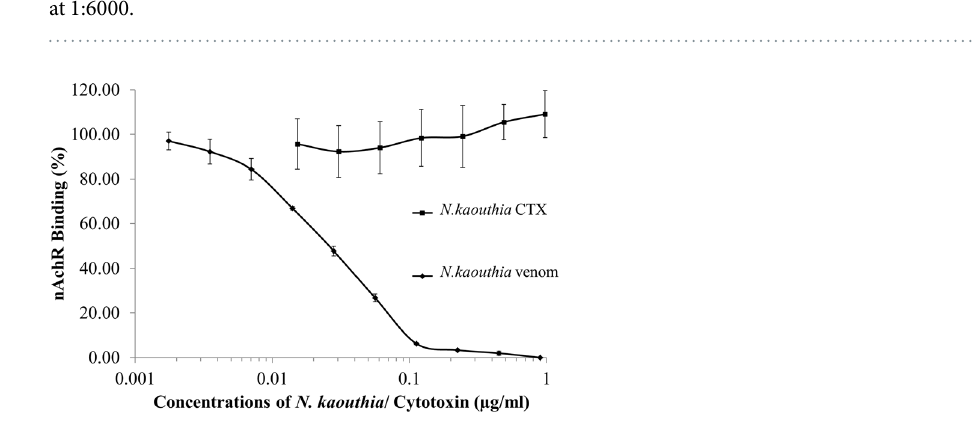
Figure 2. The inhibition of nAChR binding to the NK3 coated-plate by N. kaouthia venom and by N. kaouthia cytotoxin I. nAChR binding were expressed as mean ± S.D. of 4